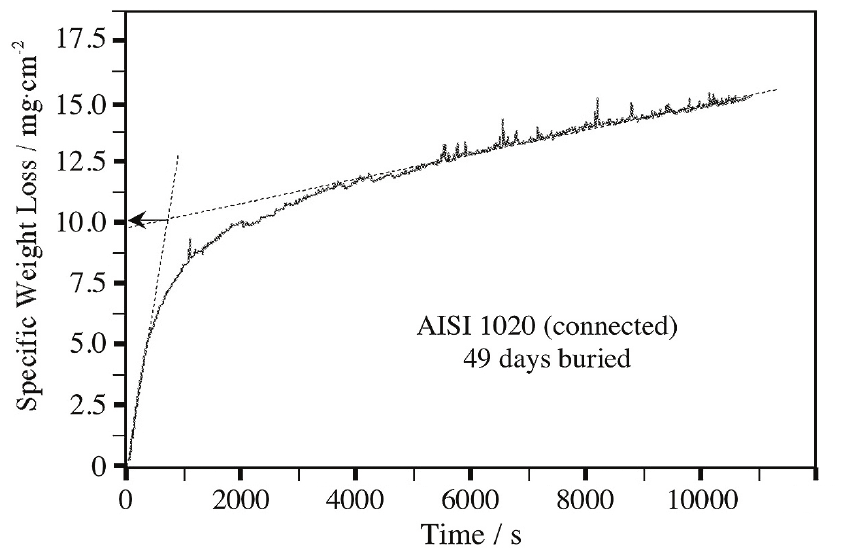
Figure 2. In situ measurement of specific weight loss during exposure of corroded sample to Clark